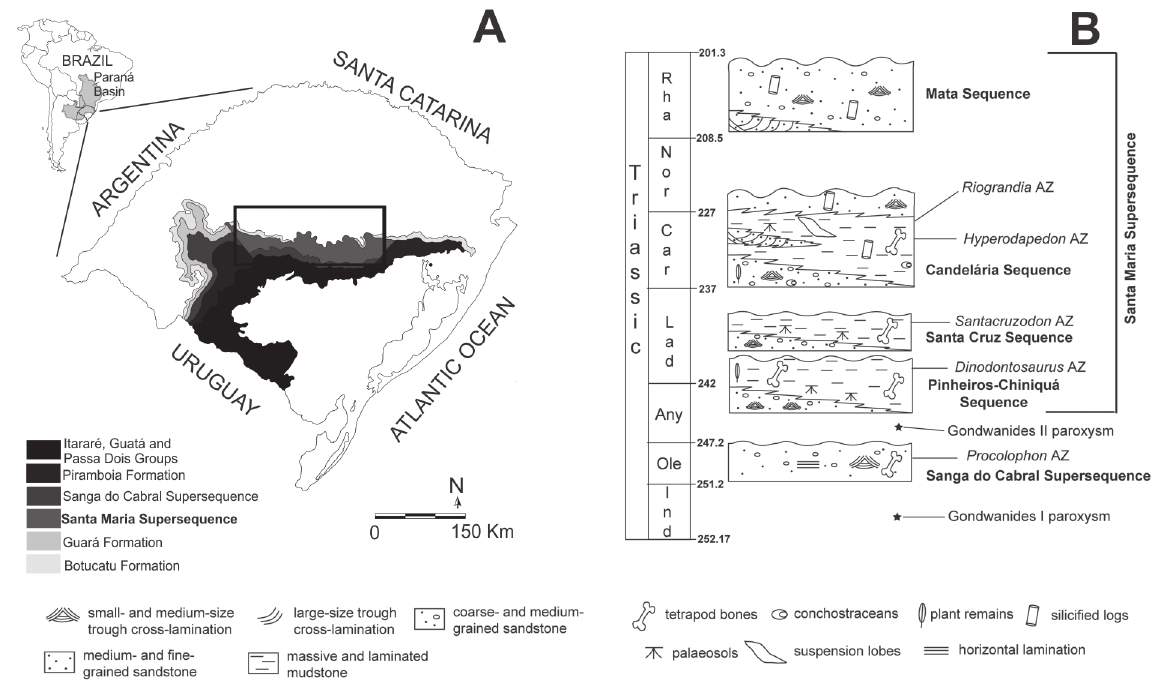
Fig. 1 - A: Geographical location of the Santa Maria Supersequence (Paraná Basin) in the state of Rio Grande do Sul, Brazil. B: Chronostratigraphy of the southern Brazilian Triassic, showing the four Assemblage Zones (AZ) based on tetrapods context. From Horn et al. 2004. Biostratigraphy after Soares et al. 2011. Abbreviations: Any , Anisian; Car , Carnian; Ind , Induan; Lad , Ladinian; Nor , Norian; Ole , Olenekian; Rha , Rhaetian. GEOLOGICAL SETTING AND